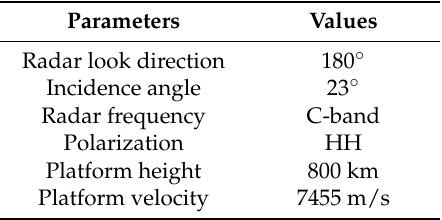
Figure 4. Simulated SAR image of an eddy. The size of the scene is 20 km × 20 km. Table 2. The simulation parameters of Figure 4.